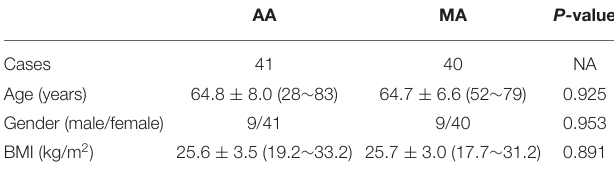
TABLE 2 | Preoperative demographic